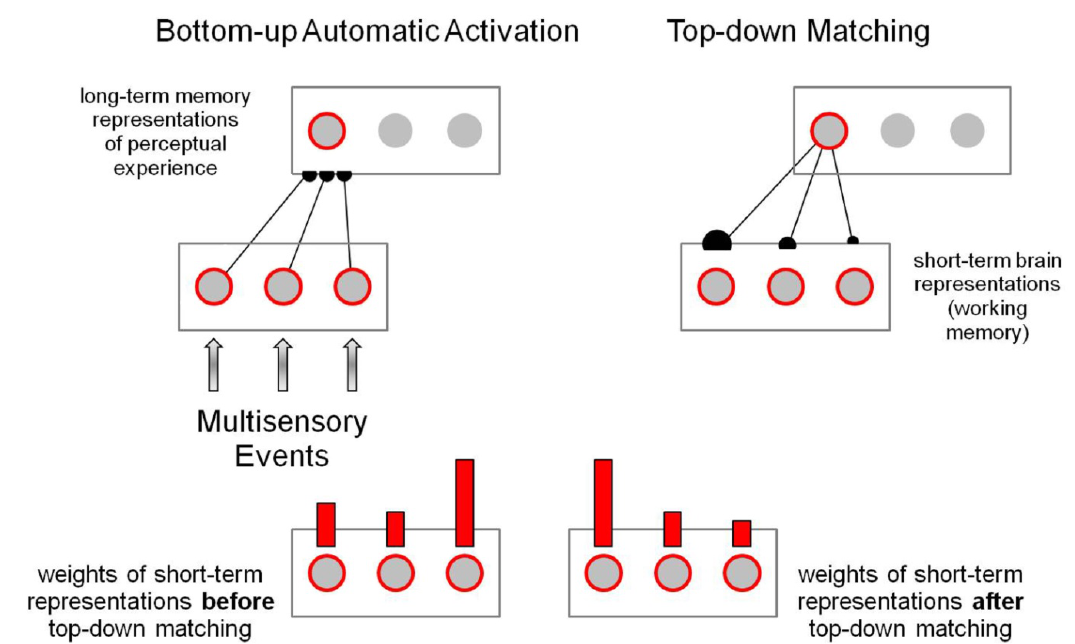
Figure 2. In the ART matching rules, bottom-up signals from the environment activate short-term memory representations in working memory, which then, in turn, send bottom-up signals towards a subsequent processing stage at which long-term memory representations are temporarily activated (top left). These bottom-up signals are multiplied by learned long-term memory traces, which selectively filter short-term representations and activate top-down expectation signals (top right) that are matched against the selected representations in working memory. The strength of the matches determines the weighting of short-term representations (bottom) after top-down matching.